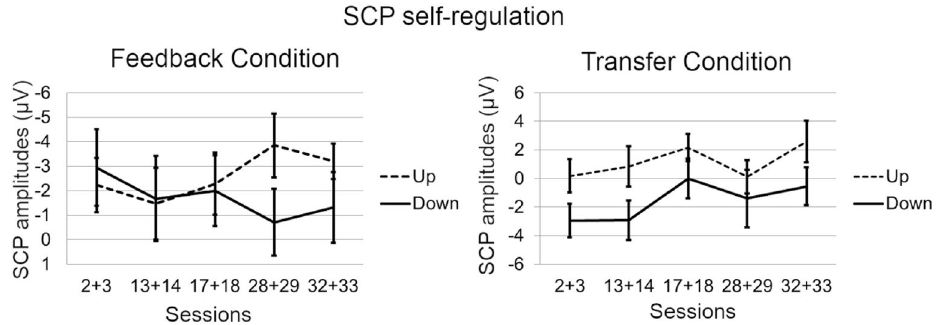
Figure 3. Self-regulation of SCP amplitude by task (polarity; upregulation vs. downregulation) and condition (feedback vs. transfer).